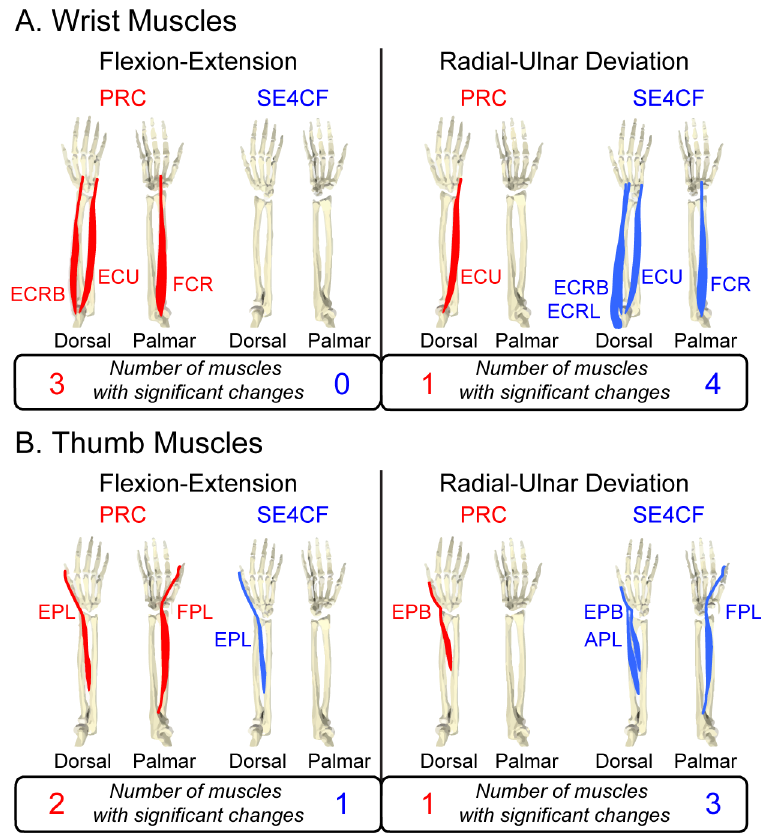
Fig 6. Significant Differences in Experimentally Measured Muscle Moment Arms. Depicted muscles indicate statistically significant differences (p < 0.05) between the nonimpaired and surgically salvaged moment arm versus joint angle curves, as measured experimentally. (A) Wrist and (B) thumb muscles are displayed separately to illustrate similar trends in how PRC (red) and SE4CF (blue) influence flexion- extension moment arms (left) and radial-ulnar deviation moment arms (right) across the two distinct muscle groups.